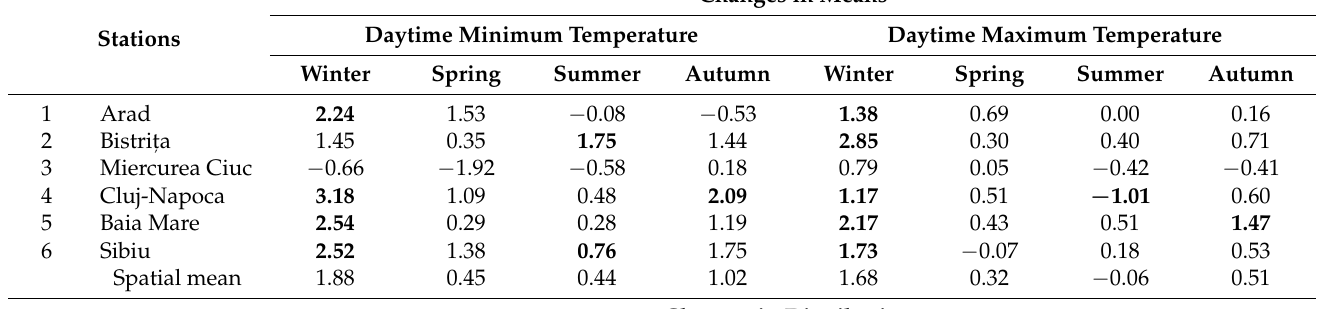
Table 3. Changes (in ◦ C) in daytime minimum and maximum temperature between historical (1871–1918) and current (1971–2020) periods in the Transylvania Region. Bold values indicate sig- nificant changes at the 0.05 significance level. Blank cells indicate no significant changes at the 0.05 significance level.